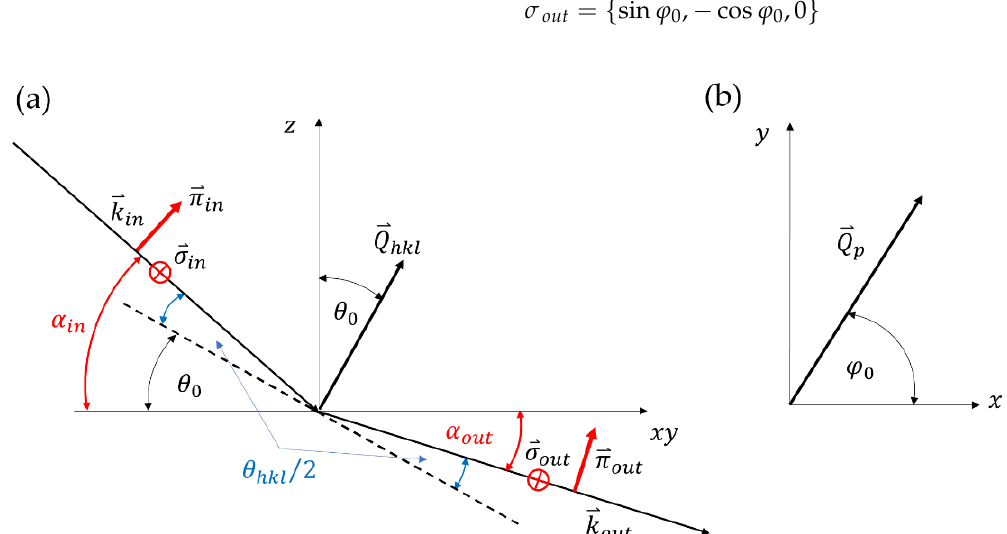
(cid:42) Q hkl is the scattering vector, Figure 4. Scattering geometry for the peak with Miller indices ( hkl ) in the laboratory system. ( a ) Figure 4. Scattering geometry for the peak with Miller indices ( ℎ𝑘𝑙 ) in the laboratory system.( a ) (cid:42) (cid:42) (cid:42) (cid:42) k in and k out are the wave vectors of the incident and scattered wave, respectively; π in and π out are in-plane components 𝑄 ⃑⃑ 𝑘 ⃑⃑ 𝑘 ⃑⃑ ℎ𝑘𝑙 is the scattering vector, 𝑖𝑛 and 𝑜𝑢𝑡 are the wave vectors of the incident and scattered (cid:42) (cid:42) σ in and σ out are perpendicular components. θ 0 is the of polarization of the incident and scattered wave, respectively, and wave, respectively; 𝜋⃑⃑ 𝑖𝑛 and 𝜋⃑⃑ 𝑜𝑢𝑡 are in-plane components of polarization of the incident and angle between the scattering vector and the z axis and θ hkl is the scattering angle. The angles between the wave vectors of scattered wave, respectively, and 𝜎⃑ 𝑖𝑛 and 𝜎⃑ 𝑜𝑢𝑡 are perpendicular components. 𝜃 0 is the angle the incident and scattered wave and the xy plane are α in and α out , respectively. ( b ) Projection of the scattering vector on the between the scattering vector and the 𝑧 axis and 𝜃 ℎ𝑘𝑙 is the scattering angle. The angles between (cid:42) xy plane ( Q p ) forms an angle ϕ 0 with the x the wave vectors of the incident and scattered wave and the 𝑥𝑦 plane are 𝛼 𝑖𝑛 and 𝛼 𝑜𝑢𝑡 , respec- tively. ( b ) Projection of the scattering vector on the 𝑥𝑦 plane ( 𝑄⃑⃑ 𝑝 ) forms an angle 𝜑 0 with the 𝑥 axis.